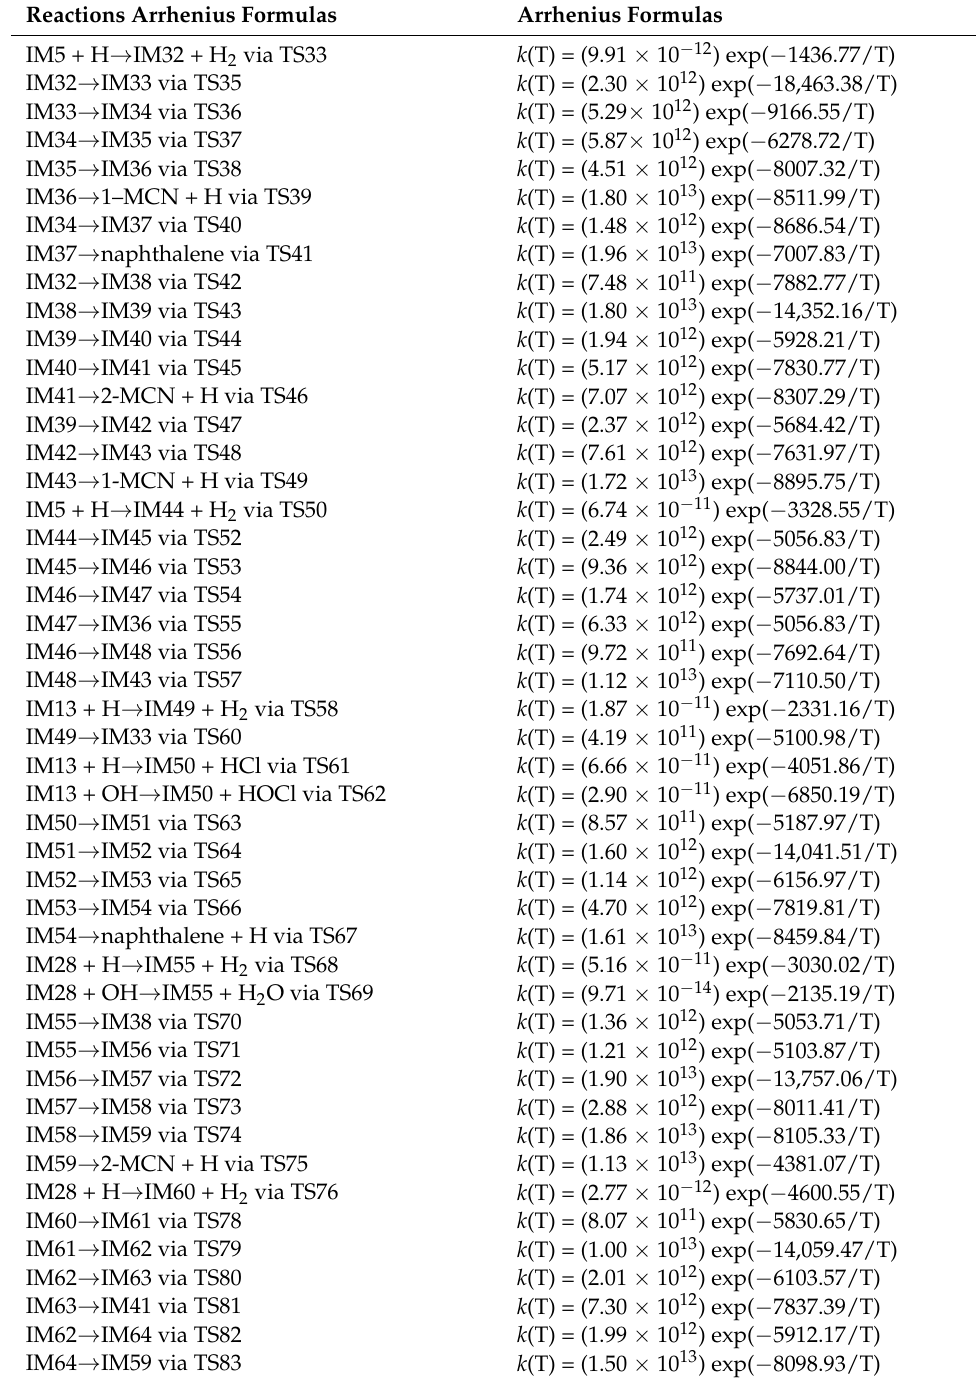
Table 2. Arrhenius formulas for chloro-bicyclopentadienyls formation routes from the cross- condensation reactions of PhR with 2-CPR over the temperature range of 600~1200 K. (Units are s − 1 and cm 3 molecule − 1 s − 1 for unimolecular and bimolecular reactions, respectively). Reactions Arrhenius